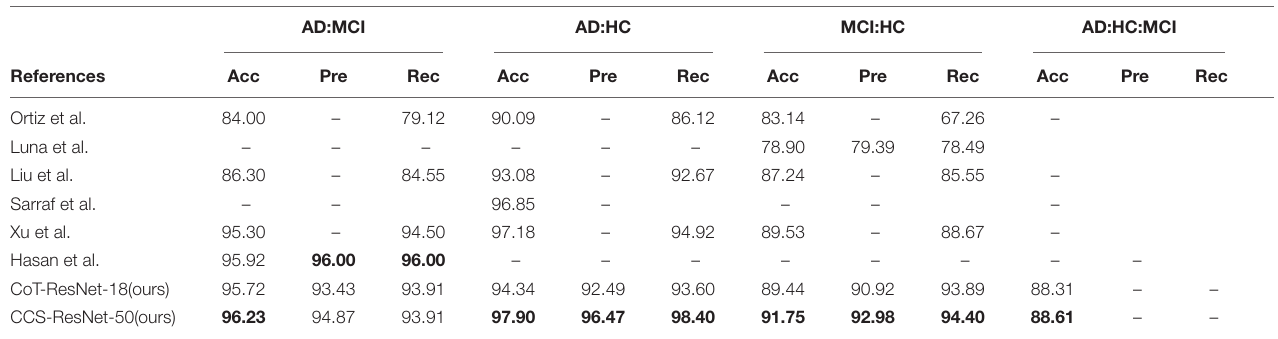
Bolded numbers indicate the maximum value of the